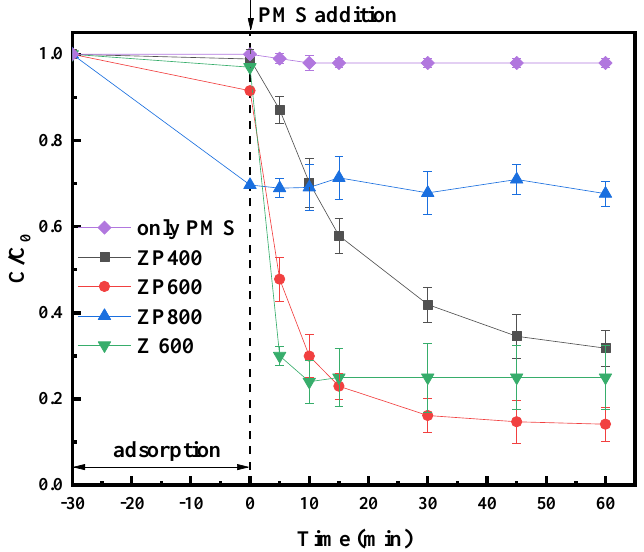
Figure 6. DMP degradation efficiency in different reaction systems within 60 min. Reaction conditions: initial pH = 8.5, catalyst = 0.1 g/L, PMS = 0.5 mM, and DMP = 6 ppm.